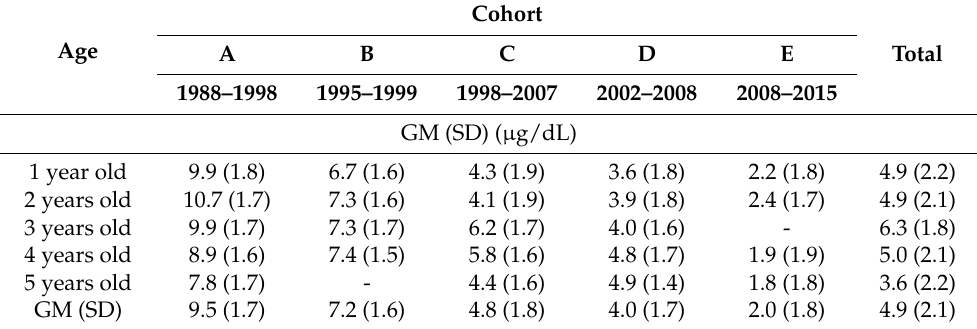
Table 2. Geometric mean (GM) for concentrations of lead in blood for each age group and